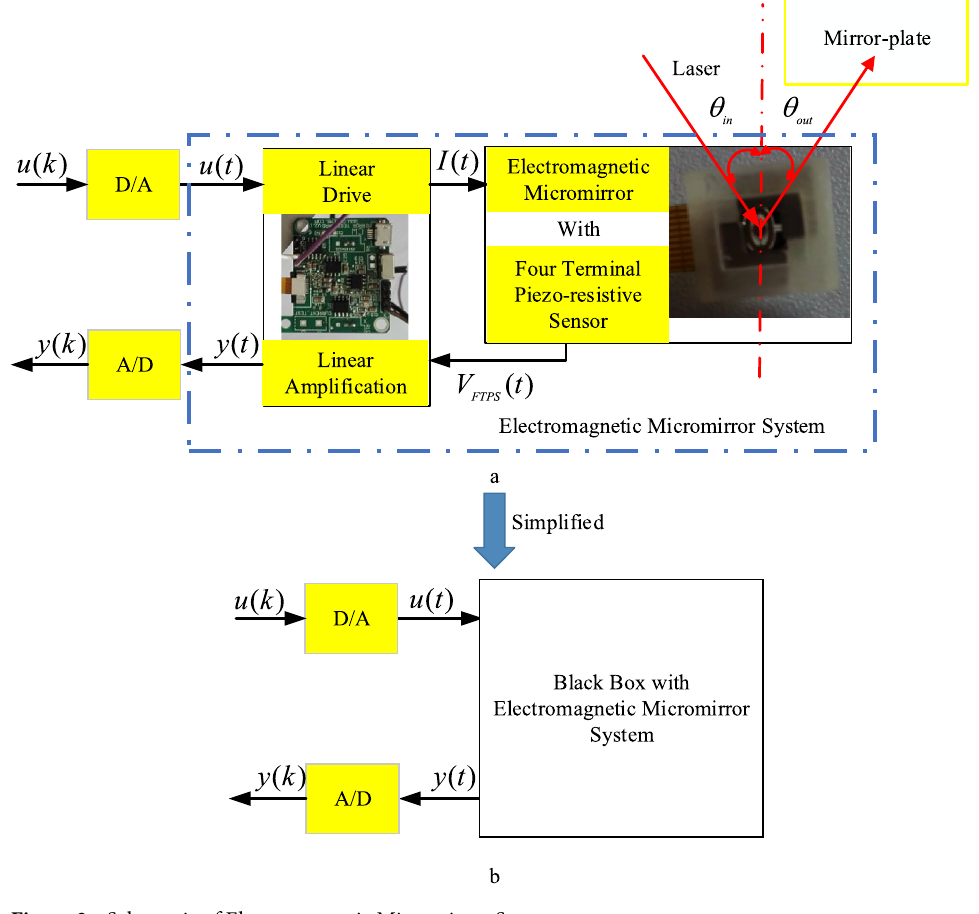
Figure 3. Schematic of Electromagnetic Micromirror